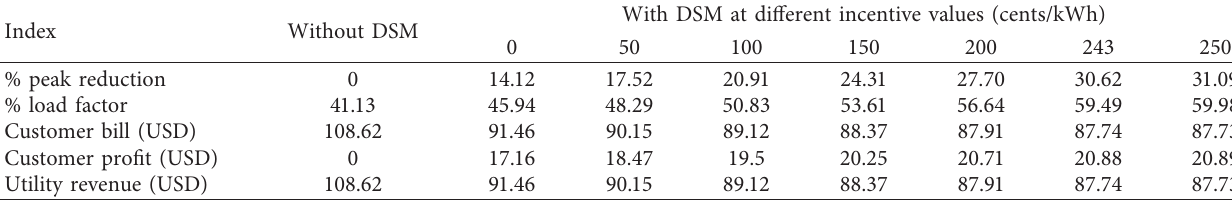
Table 5: Result summary of different technical and economical indices before and after applying LS DSM at different incentive values.